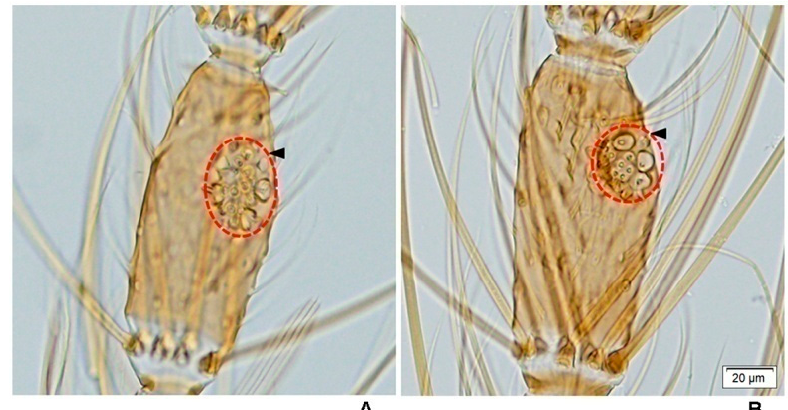
Figure 7. The cluster of large sensilla coeloconica located in sunken depression (sacculus) on the 5th antennal flagellomere of An. argyropus ( A ) and An. peditaeniatus ( B ), photographed under a compound microscope. Scale bar: 0.02 mm.